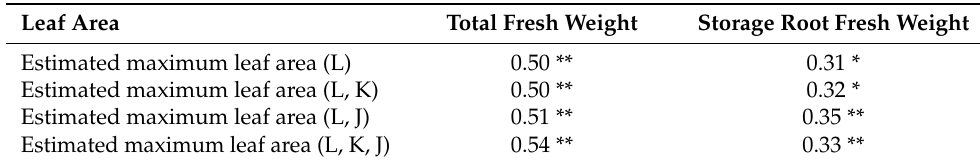
Table 3. Correlation coefficient ( r ) between biomass and estimated maximum individual leaf area as a function of the length of the central lobe (L), the product of the length and width (K), and the product of the length and number of lobes (J). Leaf Area Total Fresh Weight Storage Root Fresh Weight Estimated maximum leaf area (L) 0.50 ** 0.31 * Estimated maximum leaf area (L, K) 0.50 ** 0.32 * Estimated maximum leaf area (L, J) 0.51 ** 0.35